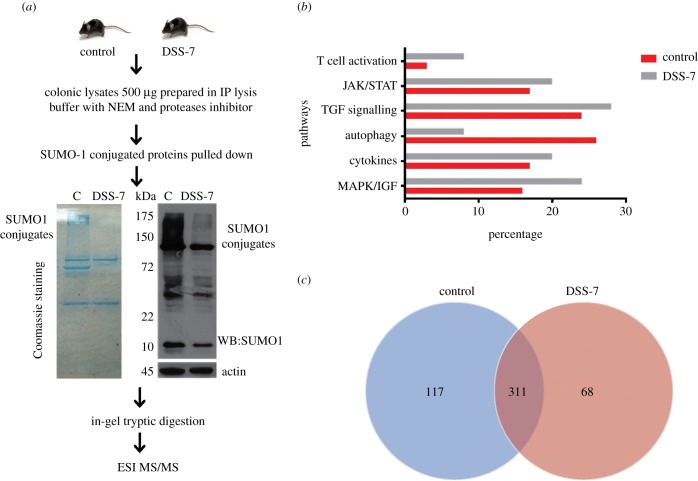
Altered SUMO1 proteome of DSS-7 mice colonic tissue samples. (a) Workflow diagram for SUMO1 proteomic analysis involving pull down of mice colonic pooled protein lysates (n = 2). Coomassie staining showing SUMO-1 immunoprecipitation (left panel) and SUMO1 immunoblots of control and DSS-7 mice samples with loading control (right panel). Five hundred micrograms of protein were used for anti-SUMO1 IP and samples were prepared using in-gel digestion for MS analysis. (b) Relative abundance of various signalling pathways based on mass-spectrometric data from DSS-7 mice compared with control mice. (c) Venn diagram displaying the number of individual proteins identified in control and DSS-7 mice samples. Venn diagram was developed using Scaffold software (v. 4.4.8, Proteome Software Inc.).